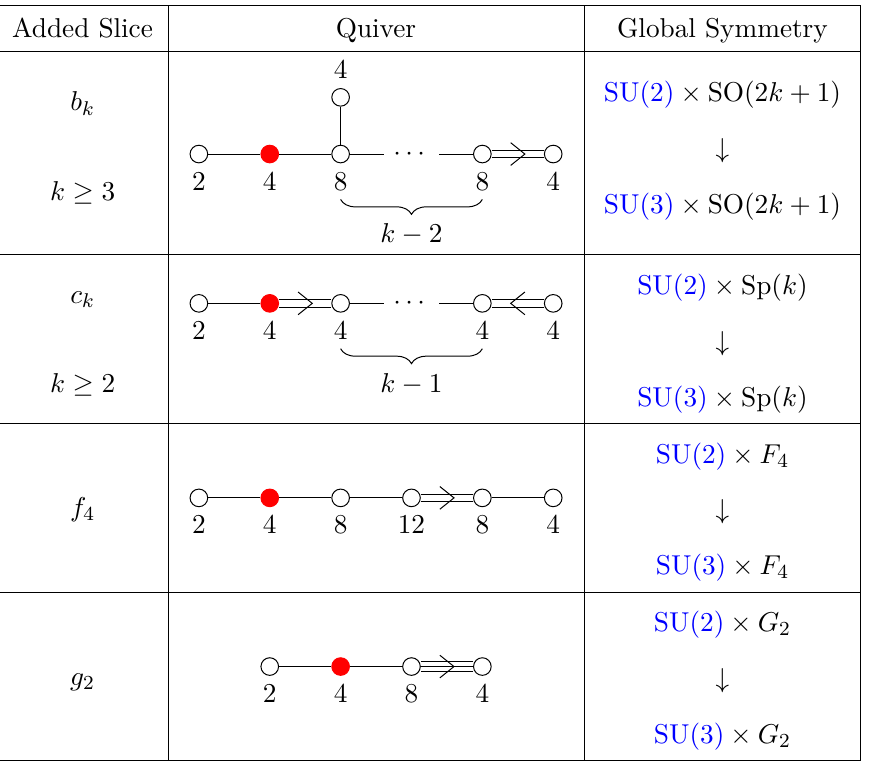
Table 21 . Quivers resulting from adding all possible non-simply laced elementary slices to (7.1) to absorb a